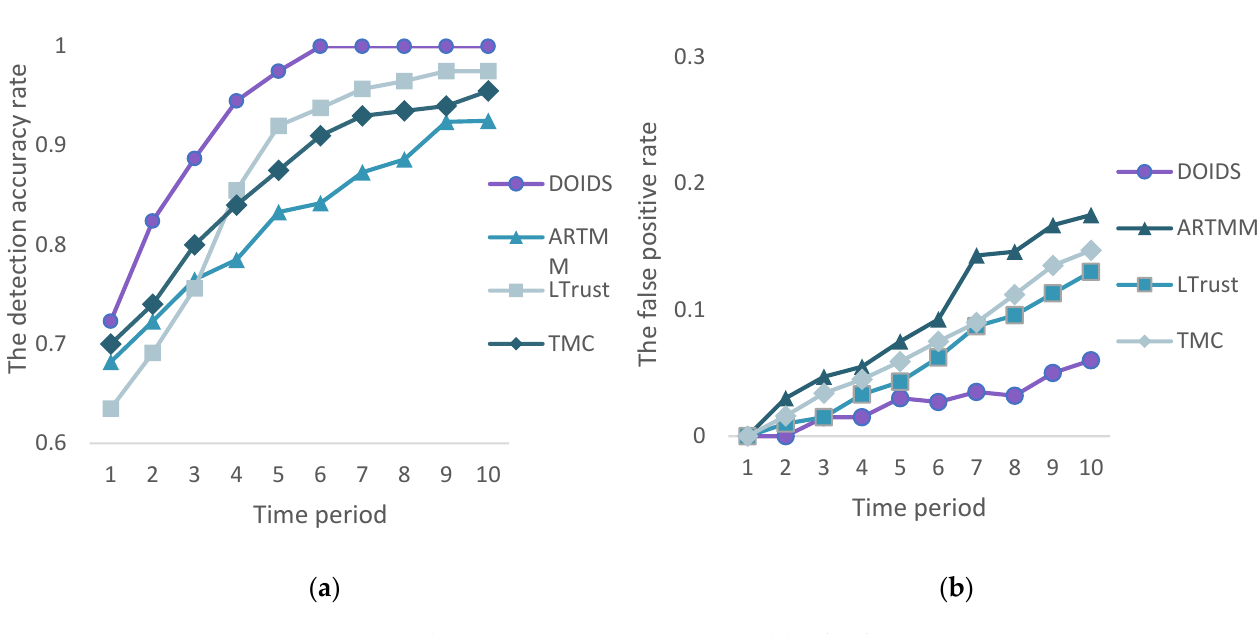
Figure 12. ( a ) Detection accuracy comparison; ( b ) False detection rate comparison.